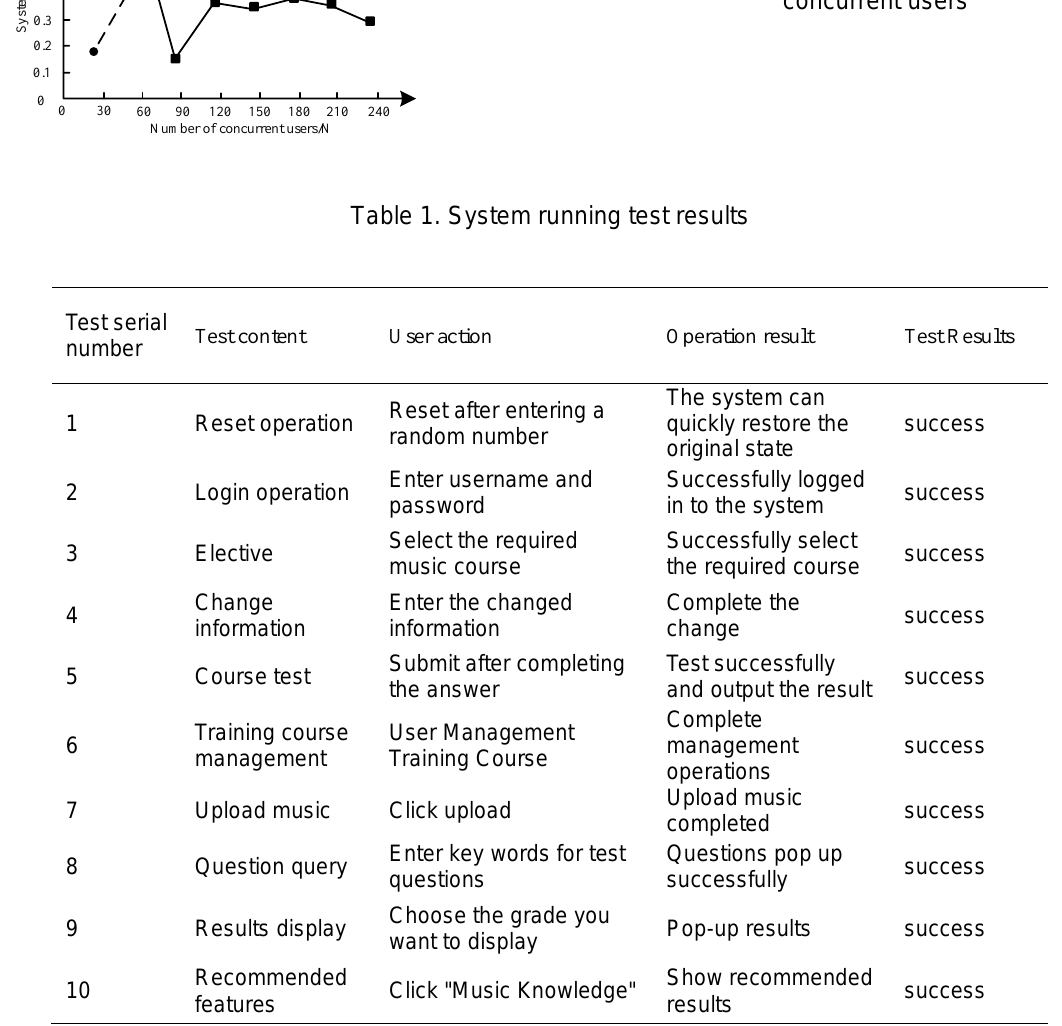
Figure 8. System response time for different concurrent users